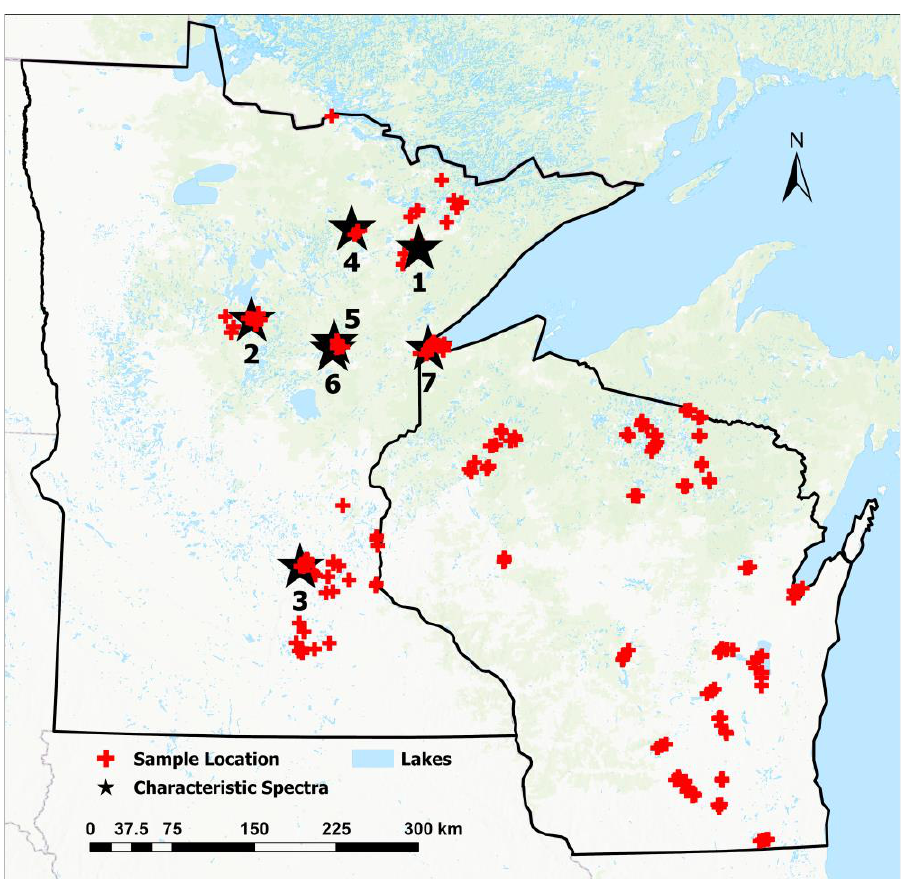
Figure 3. Locations of MNWI hyperspectral measurements. Numbered stars 1 – 7 are the locations of sites with hyperspectra discussed in Results Section 4.1 and shown in a later figure.